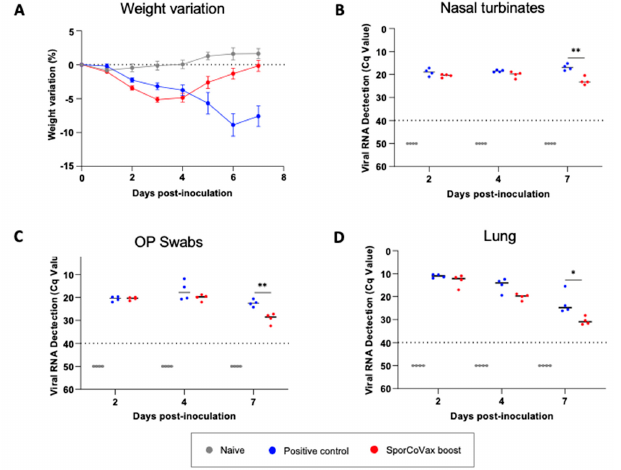
Figure 5. Protection in golden Syrian hamsters. Golden Syrian Hamsters were primed (i.m.) with recombinant spike (rS Wuh ) protein followed by two intranasal boosts with 2.5 × 10 9 spores of SporCoVax (1:1 mixture of CotB-RBD Wuh and CotC-HR1-HR2 Wuh spores) (Group 3). Negative, unvaccinated, (Group 2) and naive (Group 1) control groups received PBS in place of immunogens. 7-days after the final boost animals in Groups 2 and 3 were intranasally challenged with SARS-CoV-2 (D614G variant, 10 4 TCID 50 /animal). Weight loss post-challenge are shown (panel A ). Animals were sequentially euthanized (2, 4, and 7 dpi), necropsies were performed, and viral load of SARS-CoV-2 were determined by qPCR in NT (panel B ), OP swabs (panel C ) and lungs (panel D ). Mann-Whitney, * p < 0.05, ** p < 0.01.